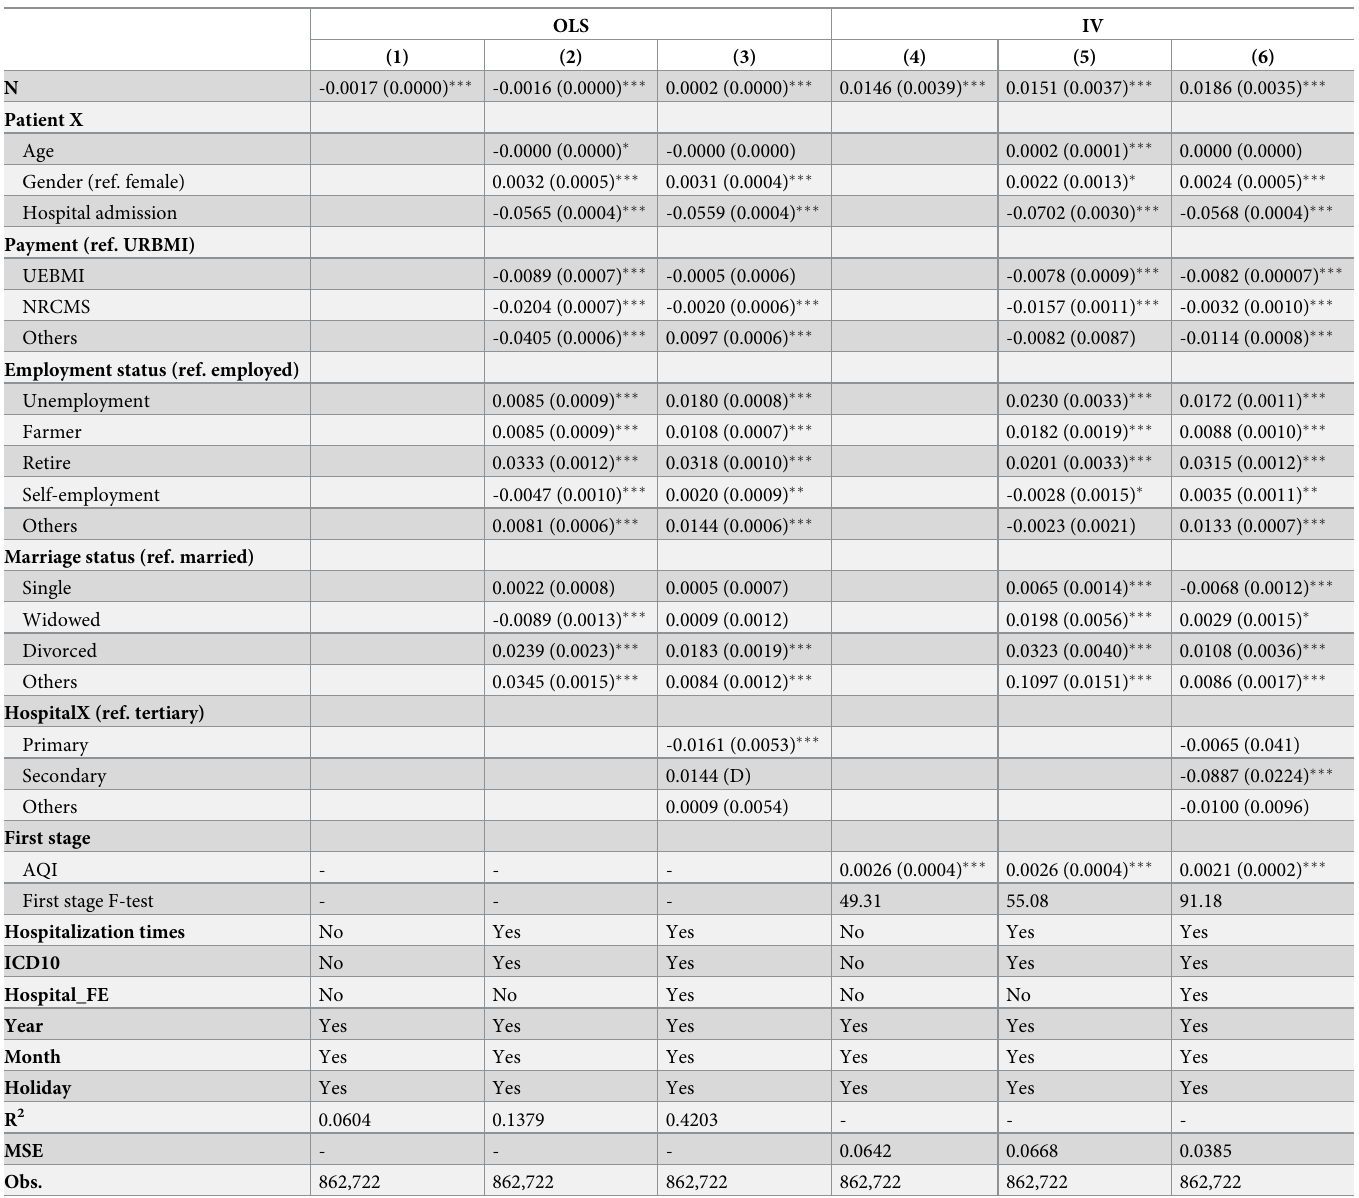
Table 4. Regression results of hospital